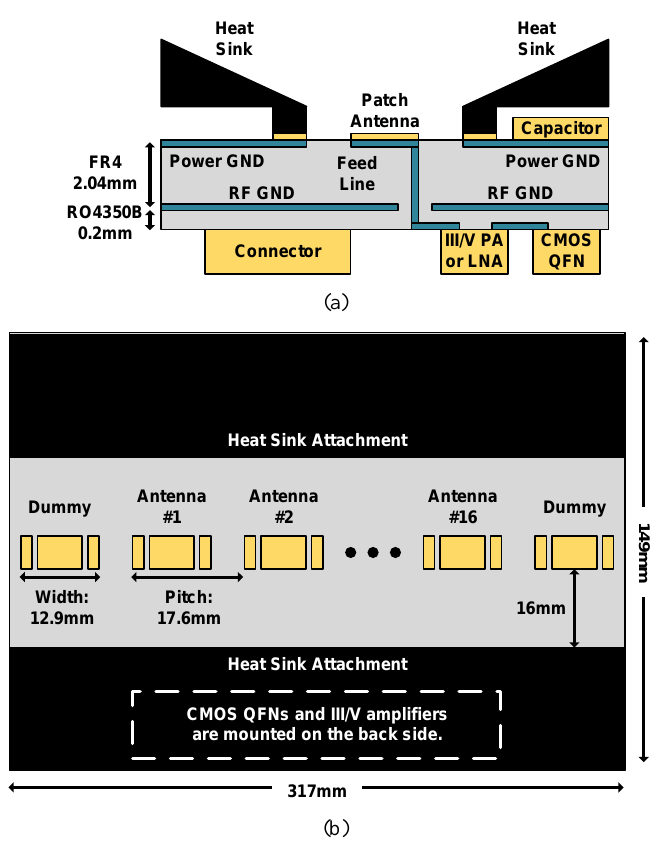
Figure 15. ( a ) Side view and ( b ) top view of a 1 × 16 interposer board.